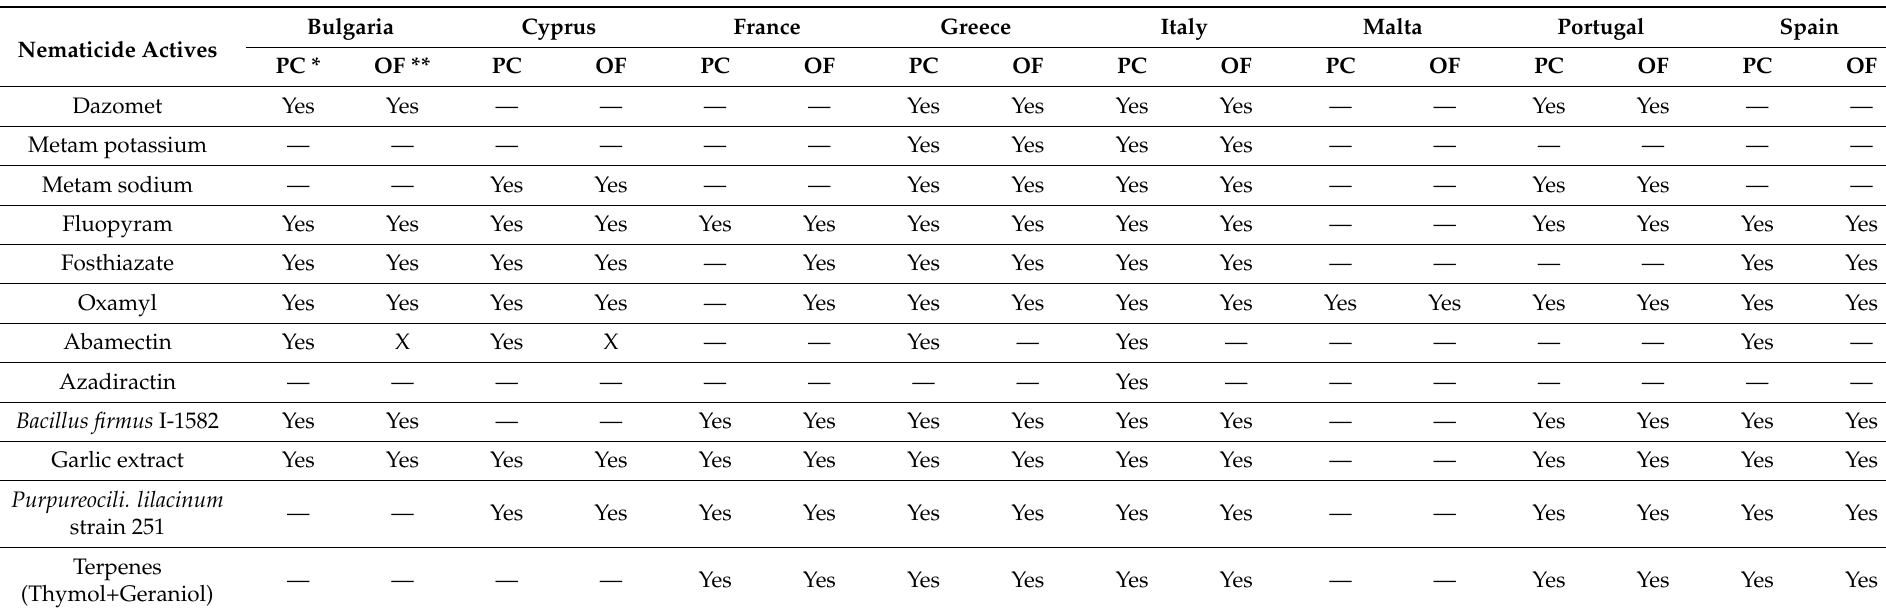
Table 1. Availability of active substances approved as nematicide products in the Southern zone of the European Union (31 May 2021). Nematicide Actives PC * Dazomet Yes Metam potassium Metam sodium Fluopyram Yes Fosthiazate Yes Oxamyl Yes Abamectin Azadiractin Bacillus firmus I-1582 Yes Garlic extract Purpureocili. lilacinum strain 251 Terpenes